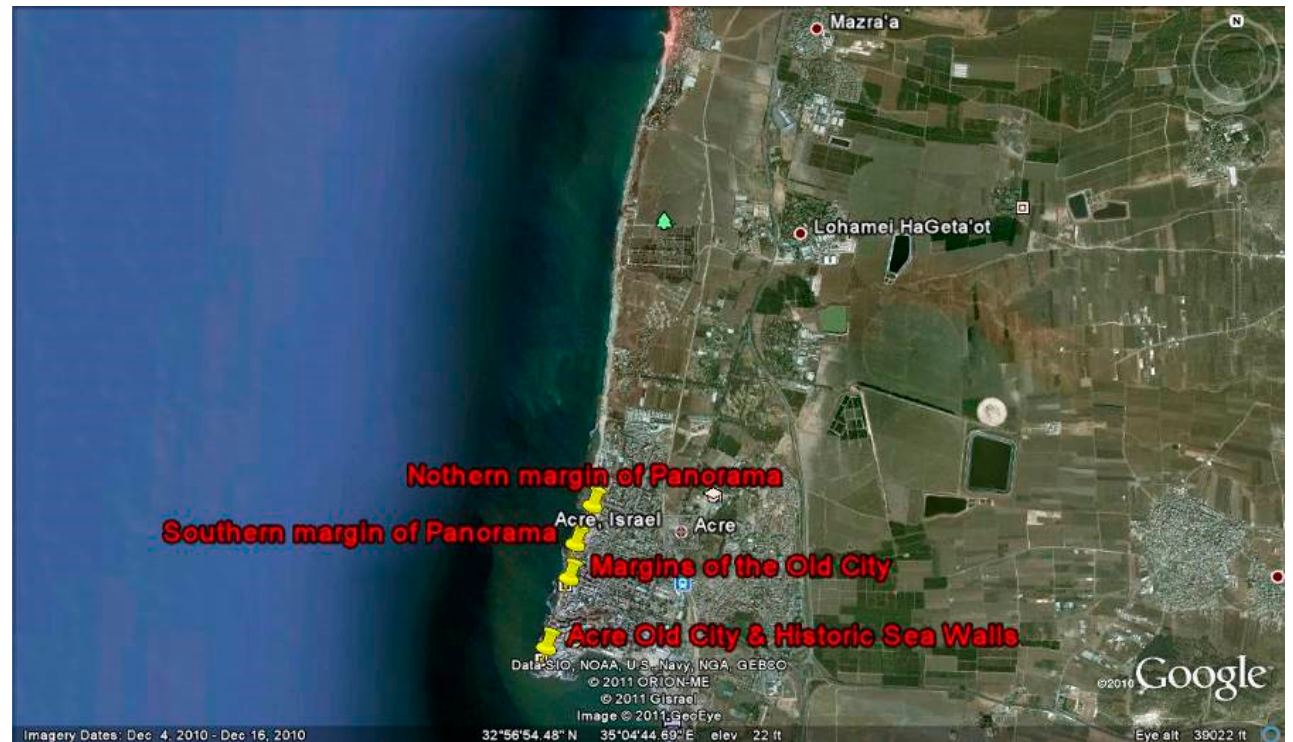
Figure 1. Google Earth Image of Acre coastal zone.